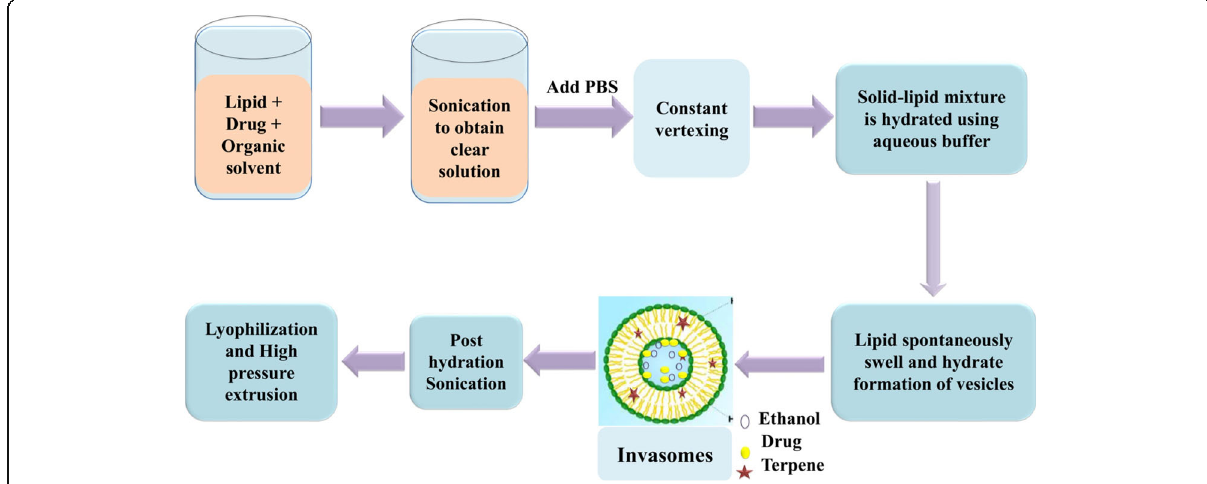
Fig. 3 Preparation of invasomes using mechanical dispersion technique